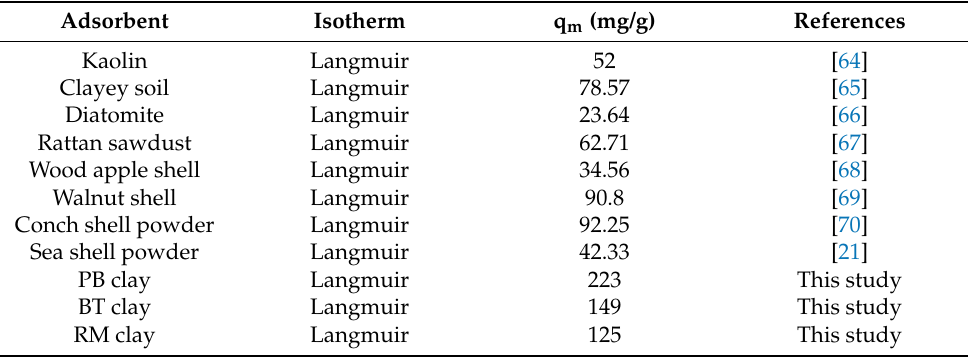
Table 5. Comparison of the maximum adsorption capacities of some adsorbents used for MG dye.